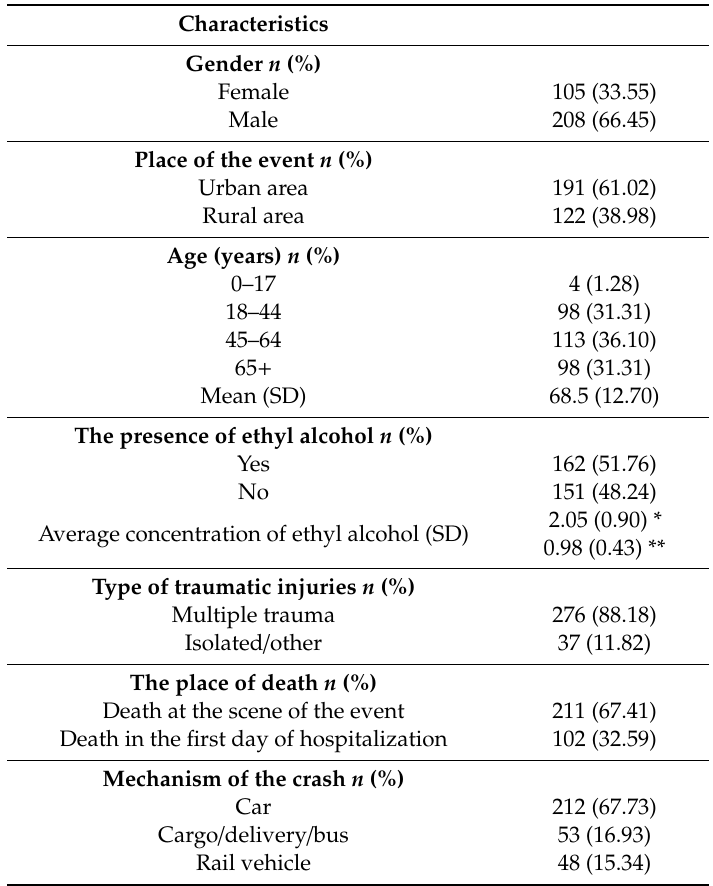
Table 1. Characteristics of the studied population.